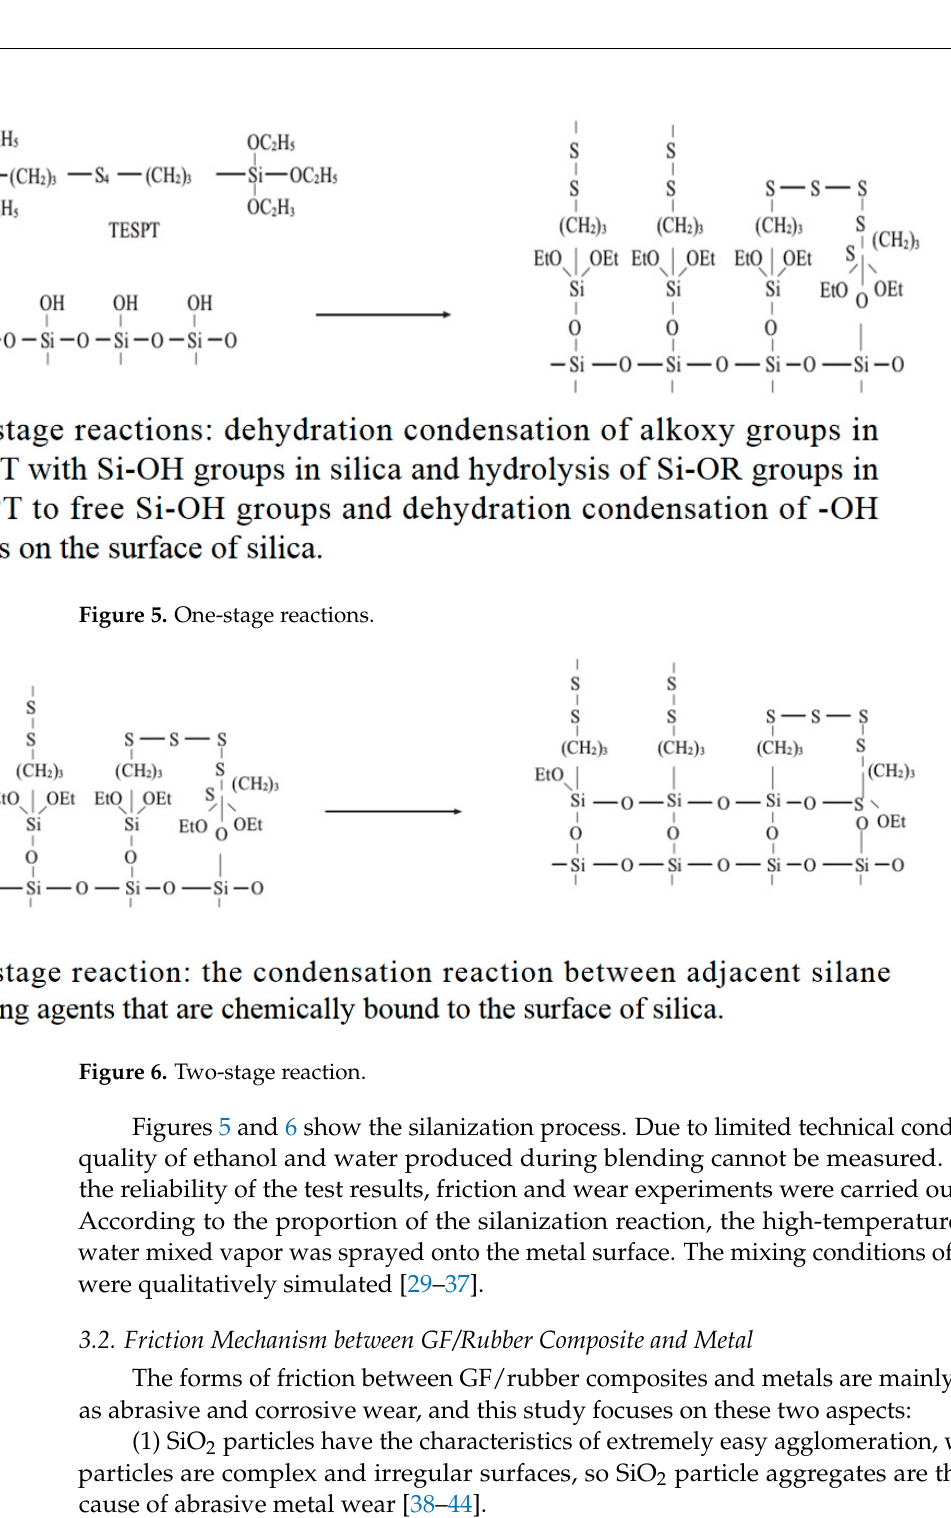
6 of 16 Figure 4. CSM friction and wear tester. (3) Metal surface observation: The metal grinding head was placed on the stage and the LEXT OLS5000 3D microscope was used to emit a laser to scan the metal surface to obtain metal surface data [26–28]. (4) Dispersion: The rubber sample was tested with a DisperGRADER disperser, and